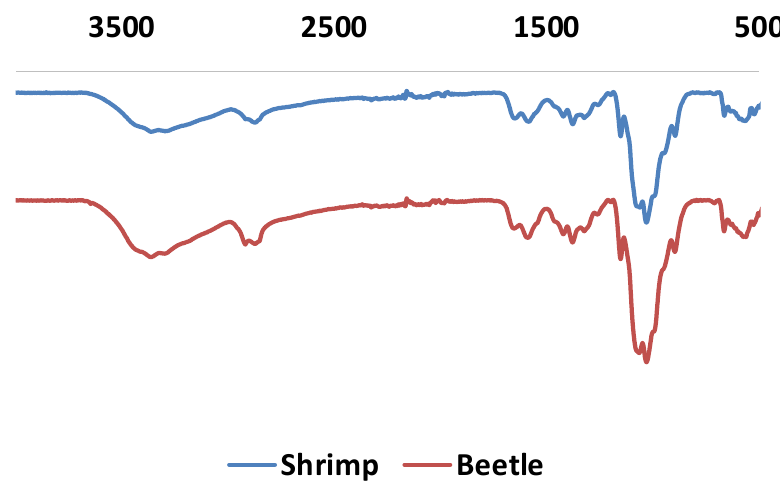
Figure 9. Infrared measurements for chitosan from shrimp (blue) and G. orientalis (red).